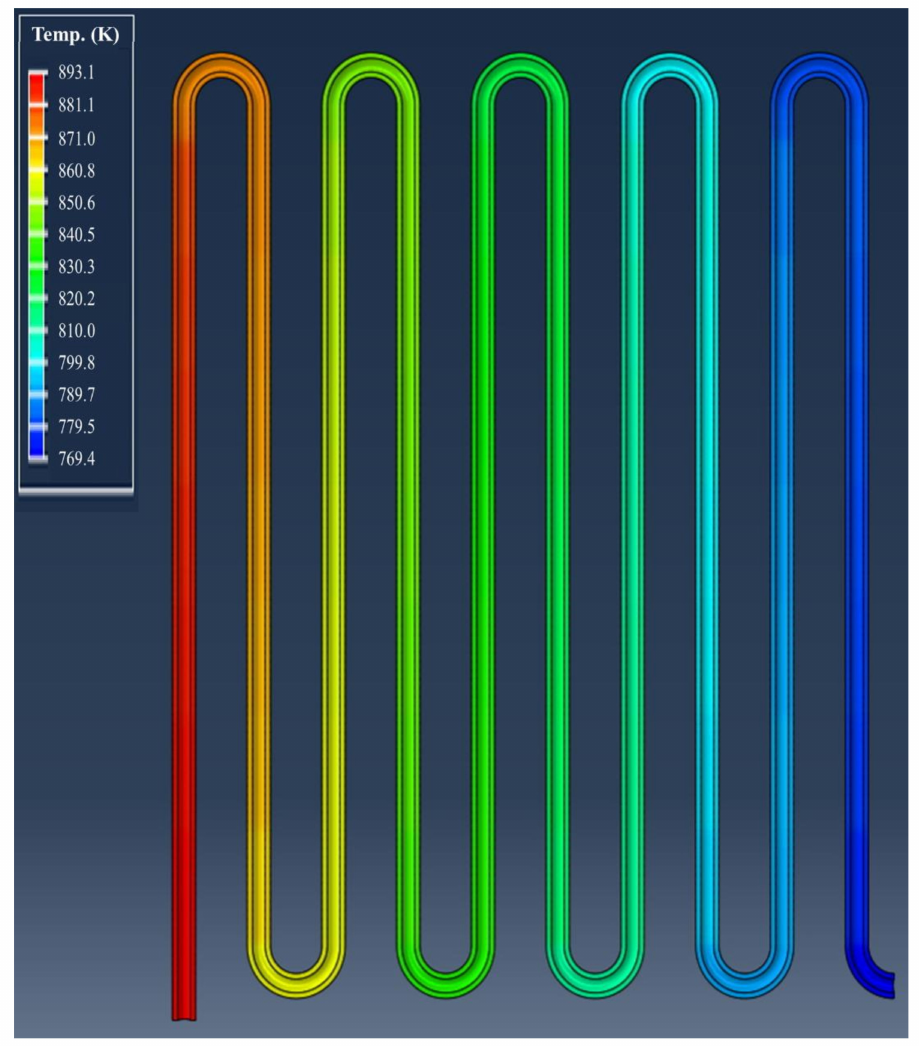
Figure 8. Heat exchanger tube temperature distributions used in the thermal stress